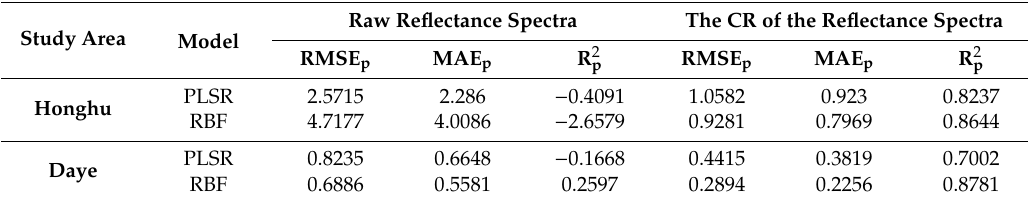
Table 2. Comparison of prediction accuracy before and after spectral pretreatment based on partial least squares regression (PLSR) and RFBNN model.